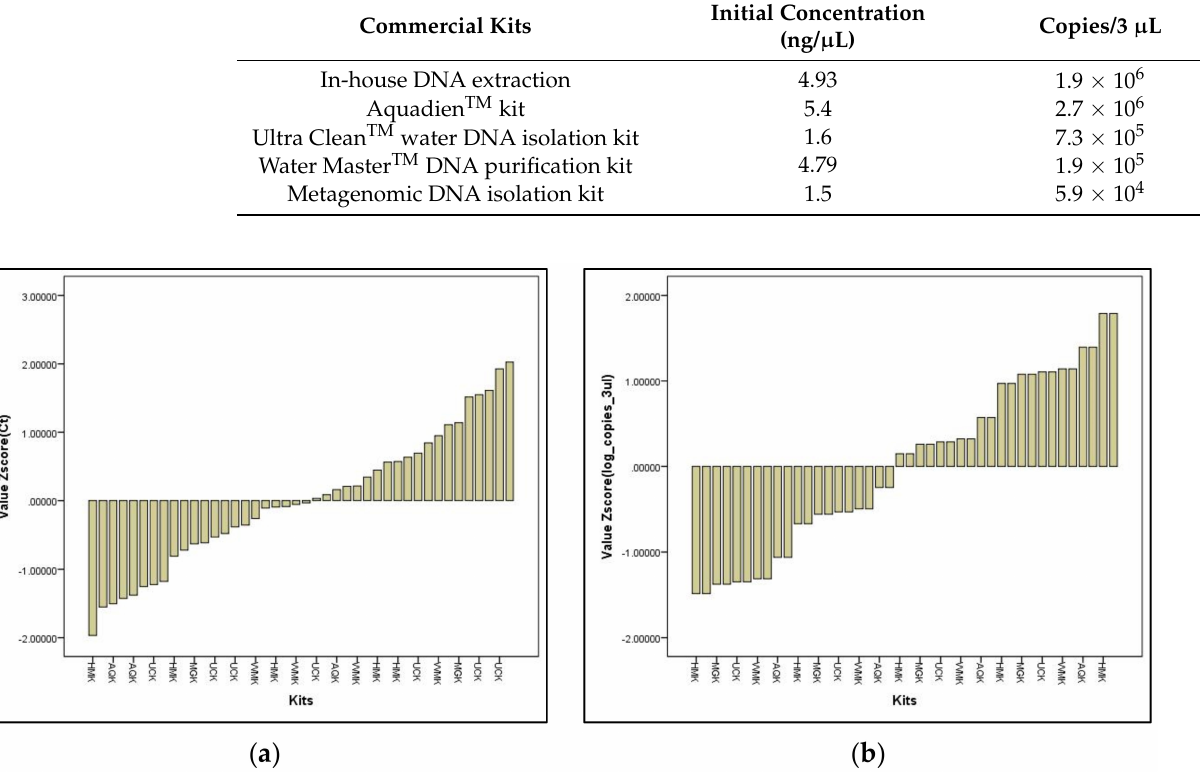
Figure 2. ( a ) Z value scores for C q for in-house DNA extraction and the commercial water-testing kits; ( b ) Z value scores for log copies/3 µ L for in-house DNA extraction and the commercial water- testing